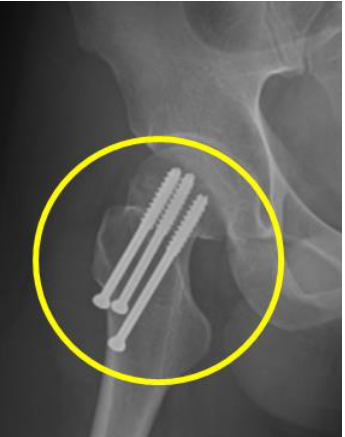
Figure 2. Lateral view X-ray of right hip femoral neck fracture, Garden type I post internal fixation of right femoral neck fracture with 6.5 mm cannulated screws × 3.